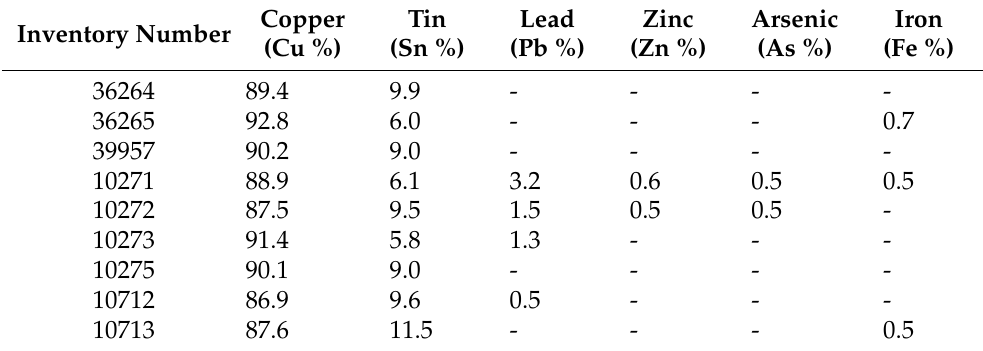
Table 2. Quantitative data expressed in weight percentages (wt %). Only the elements present in quantities greater than 0.5 wt % are reported.